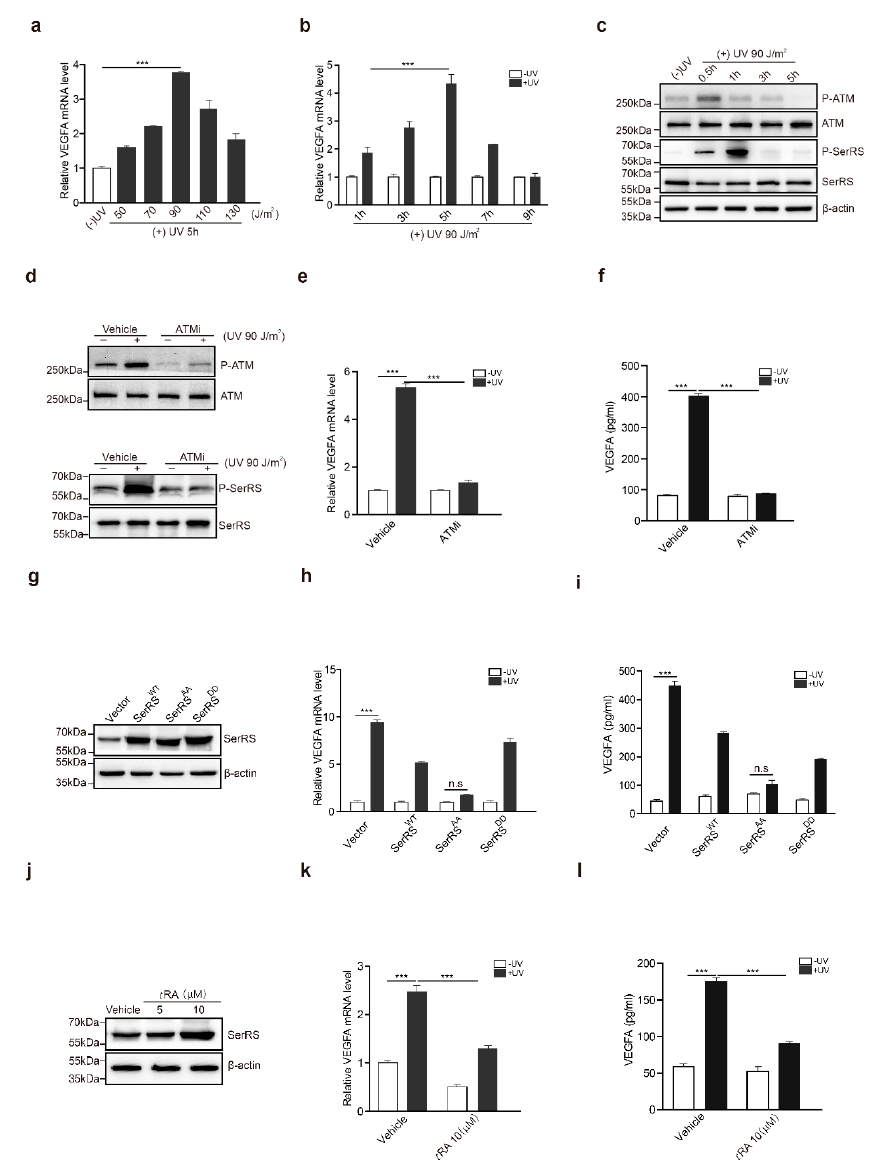
Figure 6. t RA and ATMi inhibited UV-induced VEGFA expression in melanoma cells. ( a ) mRNA levels of VEGFA in B16F10 cells with or without UV radiation were analyzed by RT-PCR. ( b ) mRNA levels of VEGFA in B16F10 cells harvested at indicated time-points were analyzed by RT-PCR. ( c ) Western blot analysis of P-ATM, ATM, P-SerRS, and SerRS expressions in B16F10 cells with or without UV treatment. ( d ) Western blot analysis of P-ATM, ATM, P-SerRS, and SerRS expressions in B16F10 cells with or without UV and KU-55933 (10 µ M) treatments. ( e ) VEGFA mRNA levels were detected by RT-PCR. ( f ) VEGFA in supernatants was analyzed via sandwich ELISA. ( g ) Western blot analysis of SerRS expression in B16F10 cells. ( h ) VEGFA mRNA levels were analyzed via RT-PCR. (i) VEGFA in supernatants was analyzed via sandwich ELISA. ( j ) Western blot analysis of SerRS expression; β -actin served as a loading control. ( k ) mRNA levels of VEGFA were analyzed by RT-PCR. ( l ) VEGFA in supernatants was analyzed via sandwich ELISA. All data above are presented as means ± SEM ( n = 3, * p < 0.05, ** p < 0.01, *** p < 0.001) of three independent